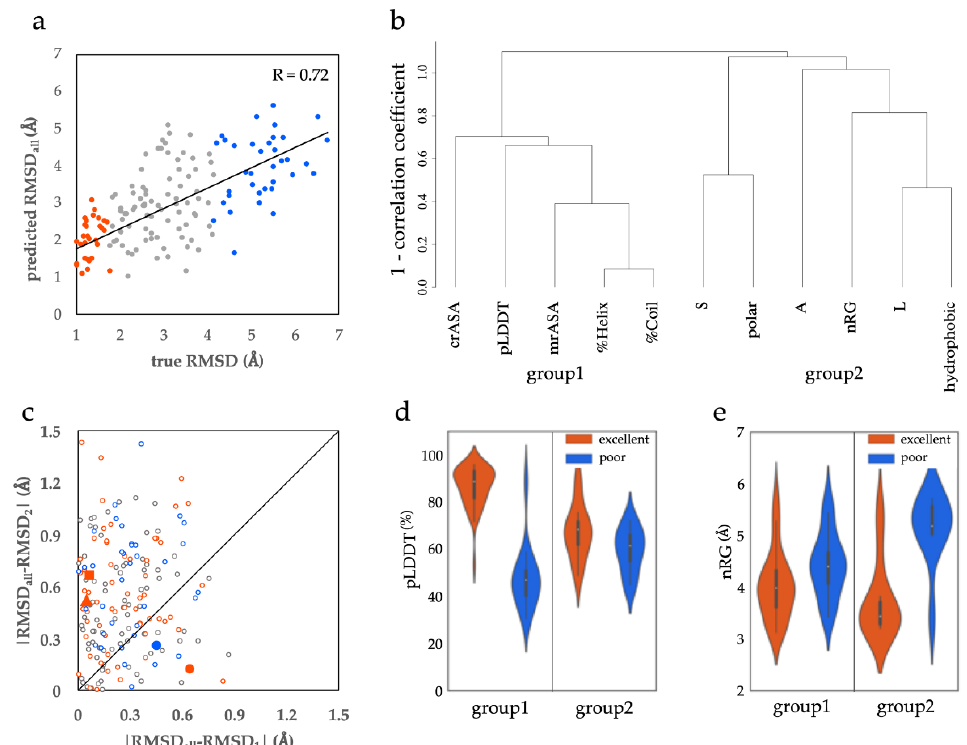
Figure 2. Grouping ProSs by 11 efficient features. ( a ) The predicted RMSDs, inferred using multiple regression with 11 features, were plotted against true RMSDs. The outliers were excluded in the multiple regression (see Figure S2). Blue, gray, and red dots represent ProSs in excellent, average, and poor classes, respectively. ( b ) Clustering of 11 features. Features located on the left and right sides are in groups 1 and 2, respectively. ( c ) Scatter plots of the absolute differences of regression results using all features and those using group 1 or 2 features. The diagonal line divides the ProSs into group 1 (upper) and group 2 (lower). Dots are colored in the same manner in the panel a). Large red and blue symbols indicate the values of examples for the ProSs in the excellent and poor groups, respectively, described in 3.1.4 and 3.1.5 (red triangle (PDB_ID: 1pq1B), red square (3i91A), red circle (2czyB), and blue circle (4rjfB)). ( d ) Distributions of pLDDT of group 1 and group 2 ProSs in the excellent and